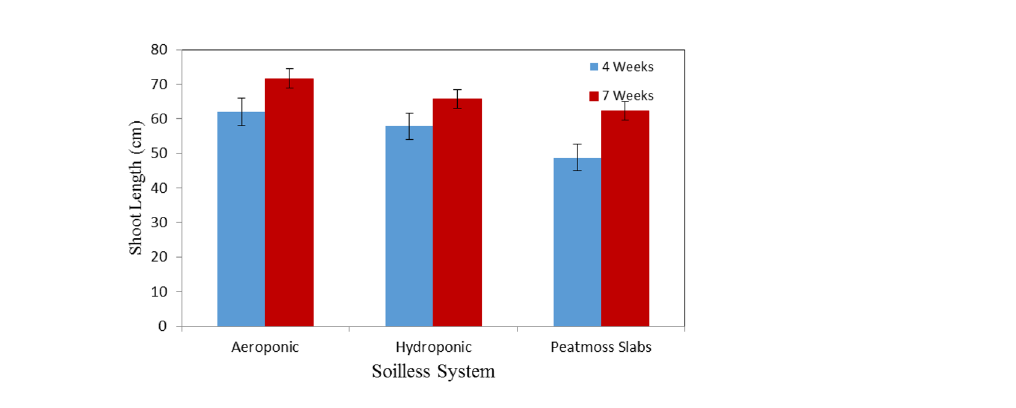
Figure 3. The shoot length of basil plants grown in different soilless